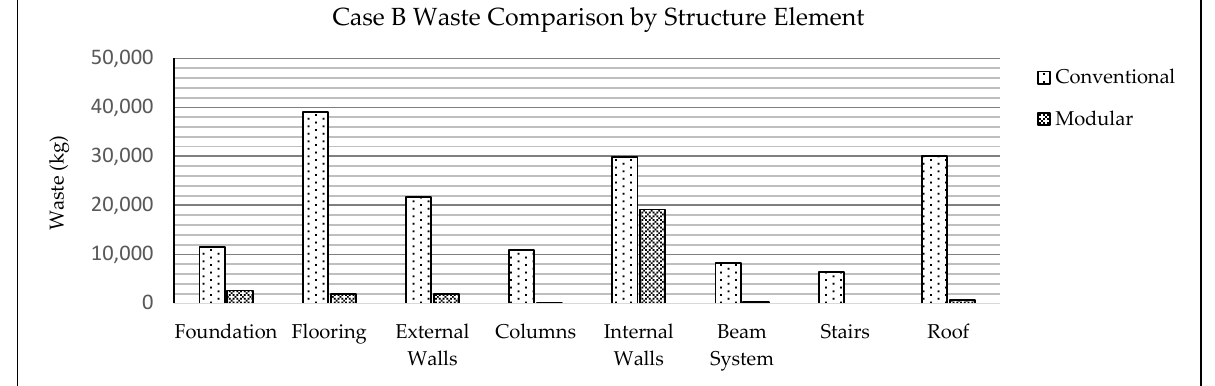
Figure 4. Case B waste comparison by structure element.